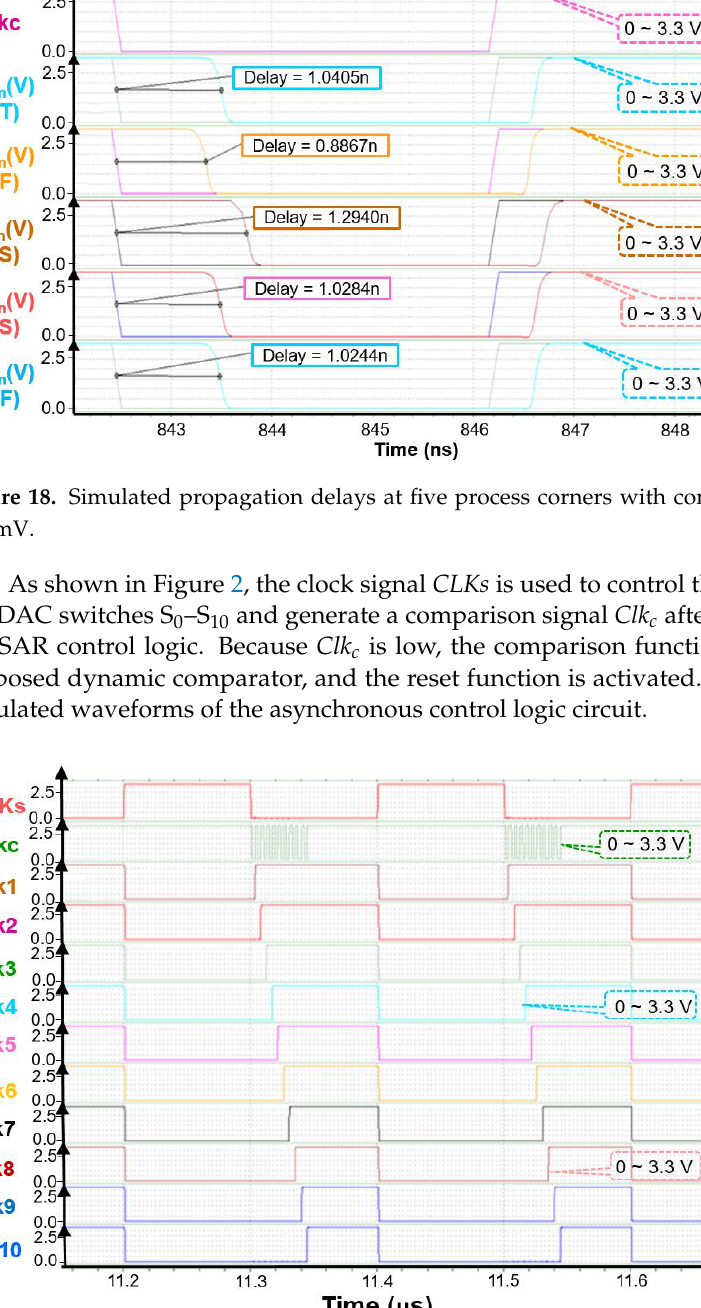
Figure 19. Simulated waveforms of asynchronous control logic circuit.